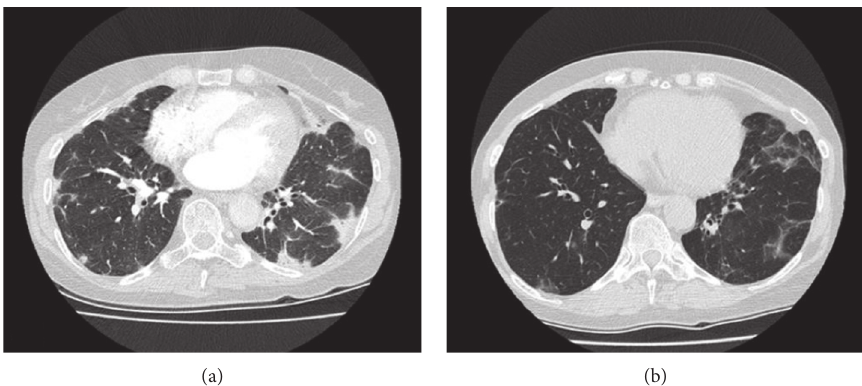
Figure 1: Imaging studies of the patient. (a) CT-thorax 2018 (pretreatment): bilateral patchy consolidations with distortion and dilatation of the bronchioles and parenchymal distortion with peripheral subpleural and peribronchovascular distribution, which are compatible with an organizing pneumonia. (b) CT-thorax 2019 (posttreatment): bilateral atelectasis with traction bronchiectasis, which are compatible with residual abnormalities after an organizing